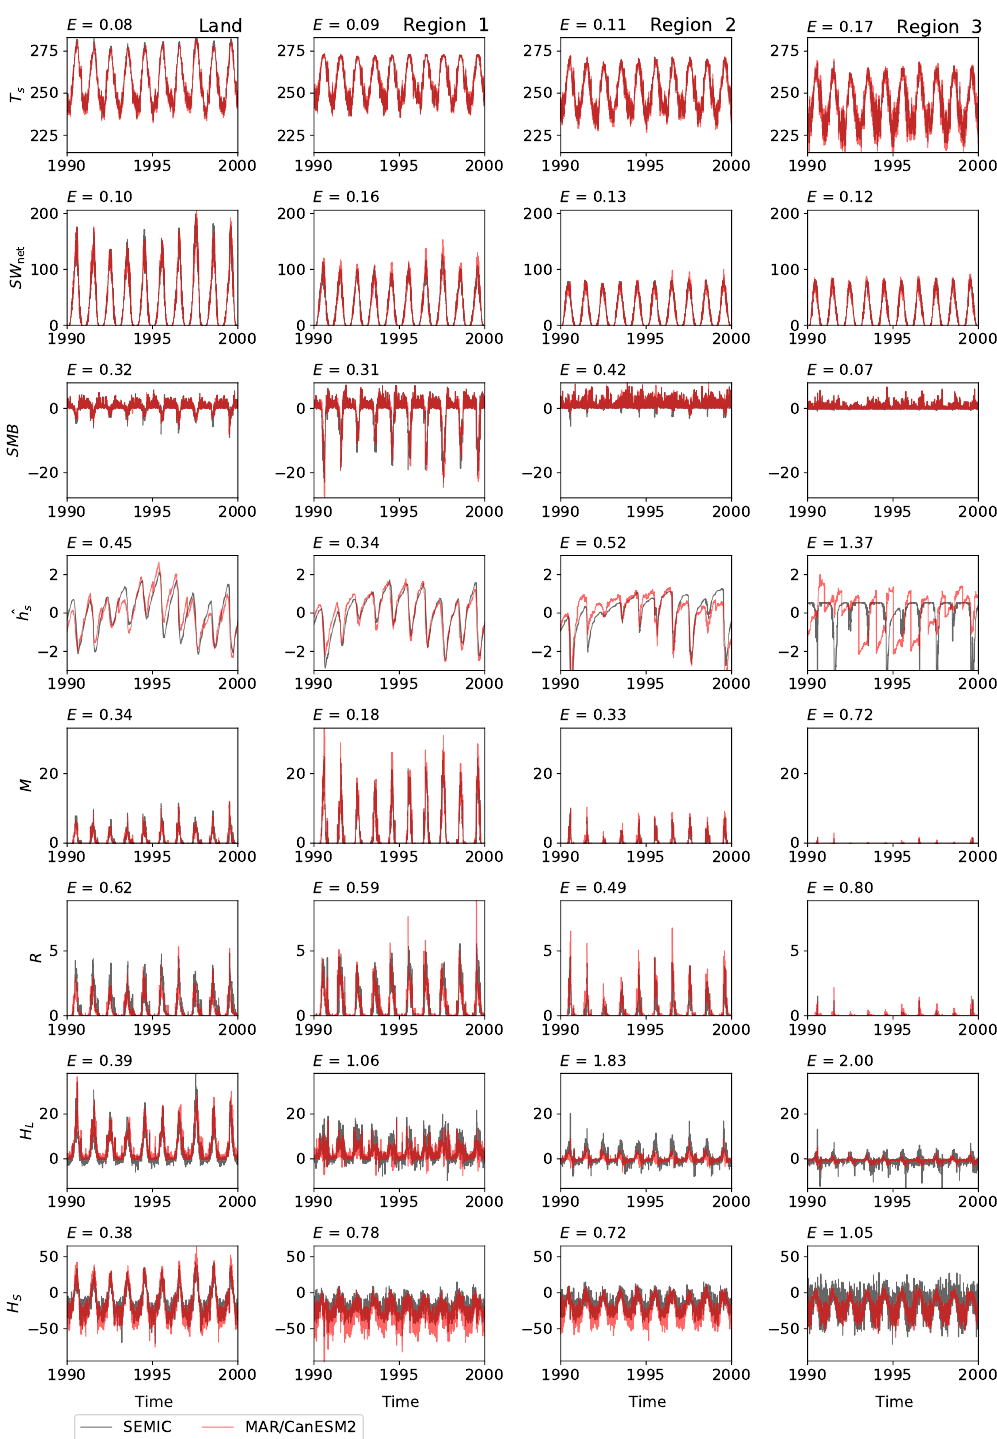
Figure 5. Time series of ice sheet averaged surface temperature T s (K), net shortwave radiation SW net (Wm − 2 ), surface mass balance SMB (mmday − 1 ), standardised snow height ˆ h s , surface melt M (mmday − 1 ), refreezing R (mmday − 1 ), latent heat flux H L (Wm − 2 ), and sensible heat flux H S (Wm − 2 ) as calculated by MAR and by SEMIC with optimal parameters from Table 3 for the years 1990–1999 of the historical period. Note that h s is scaled via its standard deviation because SEMIC and MAR incorporate a different criterion of maximum snow height (5m in SEMIC; more than 10m in MAR). The annotated number on the top left of each frame is the computed centred root mean square error as defined in Eq. (19), and it marks the distance to the reference field as shown in the Taylor diagram Fig.